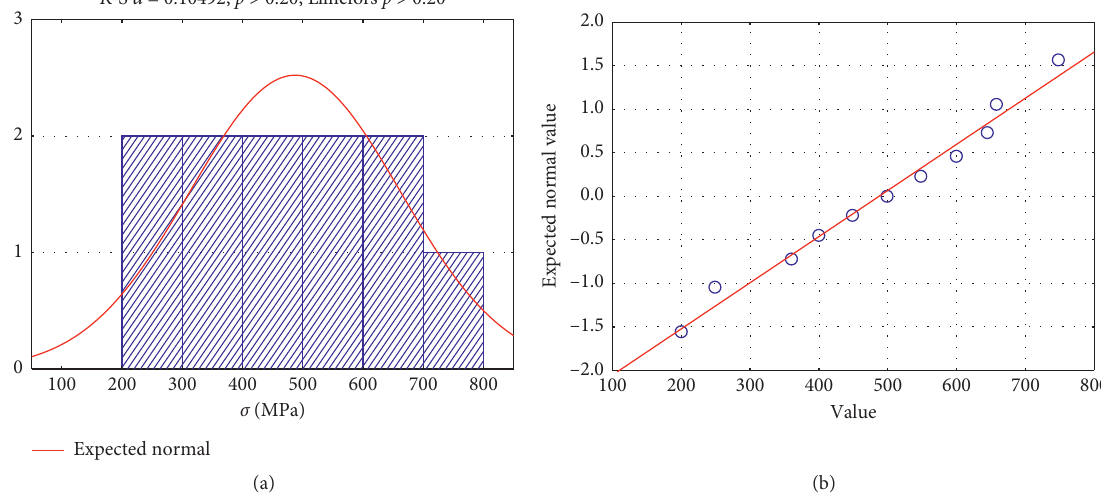
Figure 7: The distribution histogram of the stress experimental values with the superimposed curve of the expected normal distribution (a) and the graph of the normal distribution (b) for the deposited samples of group III.